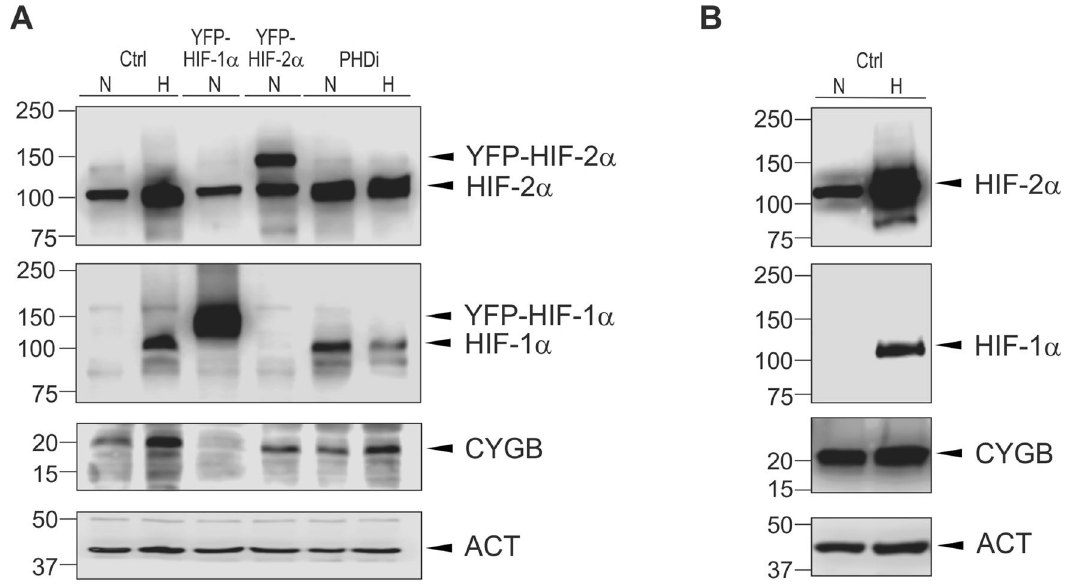
Figure 5. CYGB protein expression is upregulated under hypoxic conditions or in presence of PHD inhibitor. Representative immunoblots of CYGB in A375 ( A ) and Malme-3M ( B ) cells after 48 h under normoxic (N) or hypoxic (H) (0.1% O 2 ) conditions, in the presence of overexpressed YFP-HIF-1α or YFP-HIF-2α (24 h), and upon treatment with 4 mM PHD inhibitor (PHDi) (24 h). HIF-1α and HIF-2α were revealed using a mouse monoclonal anti-HIF-1α or a rabbit monoclonal anti-HIF-2α antibody, respectively. CYGB was detected with a rabbit polyclonal anti-CYGB antibody. β-actin (ACT) was used as a loading control and revealed using a rabbit monoclonal anti-β-actin